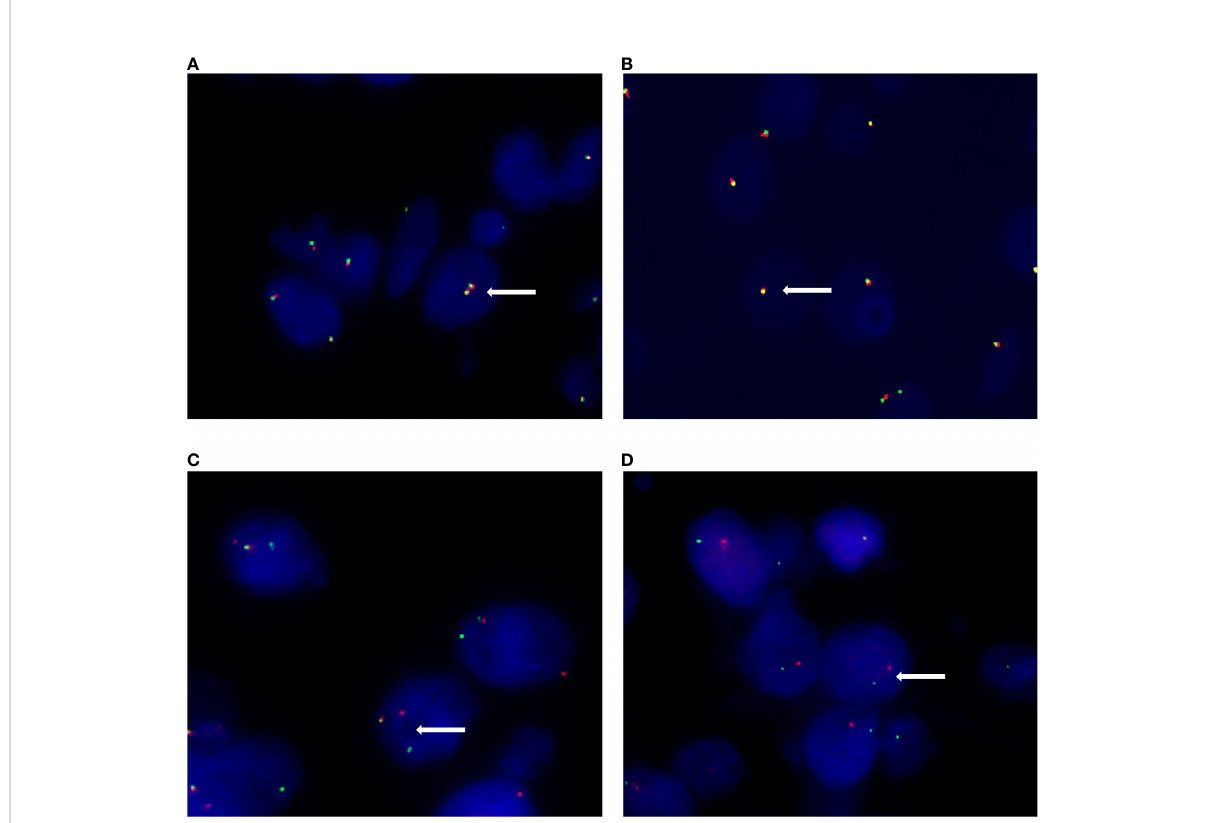
FIGURE 2 Different signal patterns in FISH staining. (A) Female patients show two pairs of fused (yellow) signal in non-Xp11.2 translocation renal cell carcinomas. (B) Male patients show one fused (yellow) signal pair in non-Xp11.2 translocation renal cell carcinomas. (C) Female patients show one fused (yellow) signal pair and an additional pair of split (red and green) signals in Xp11.2 translocation renal cell carcinomas. (D) Male patients show one signal pair of seperated red and green signals in Xp11.2 translocation renal cell